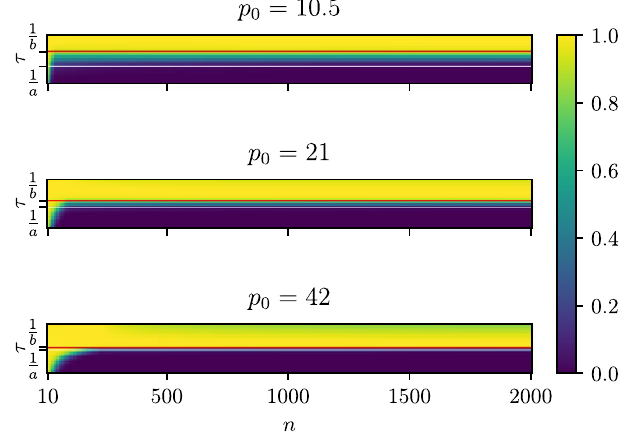
Figure 1. Entropy of the Gibbs state as a function of the parameter τ and the dimension of the graph, n for the Erdős–Rényi model. The value of the entropy is normalized by dividing by log n . The phase transition can be easily seen. We show results for three values of the parameter p 0 . The horizontal lines mark the theoretical boundaries for τ found in Theorem 10 and Remark 11. The red line marks τ = 1 b while the white one corresponds to τ = 1 a .